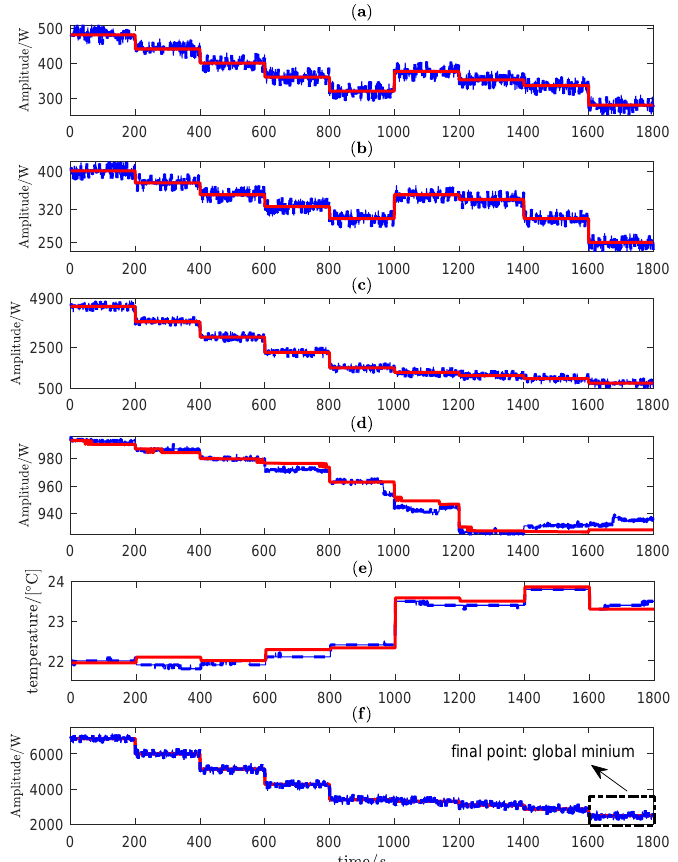
Figure 11. The measured (blue dash) and estimated (red solid) output variables for validating optimization results: ( a ) P SA , ( b ) P CW , ( c ) P CHW , ( d ) P chiller and ( e ) T in p, as well as the total power consumption (f) P total = P chiller + P CHW + P CW + 2 P SA